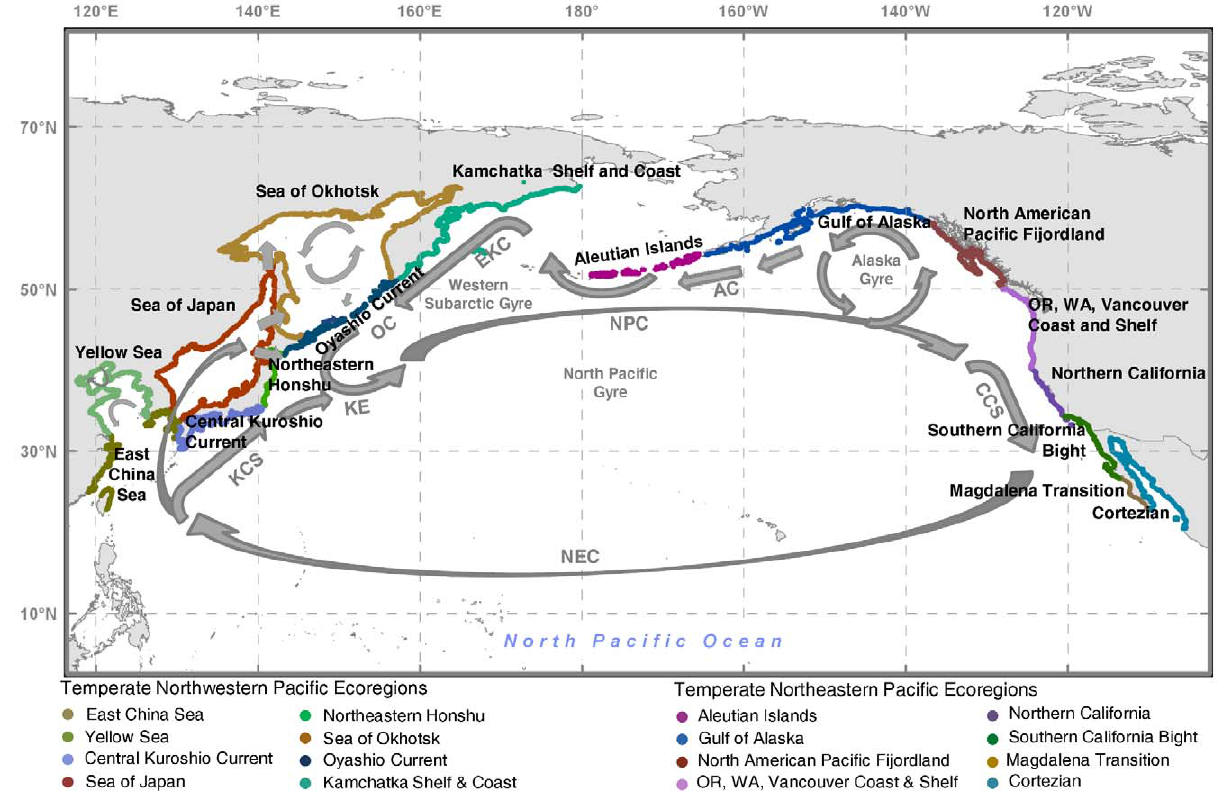
Figure 1. Temperate North Pacific realm, and the 16 MEOW ecoregions included in this paper. Major surface circulation pathways are labeled on the map and indicated with blue arrows, including the North Pacific Current (NPC), California Current System (CCS), North Equatorial Current (NEC), Kuroshio Current System (KCS), Kuroshio Extension (KE), Oyashio Current (OC), East Kamchatka Current (EKC).